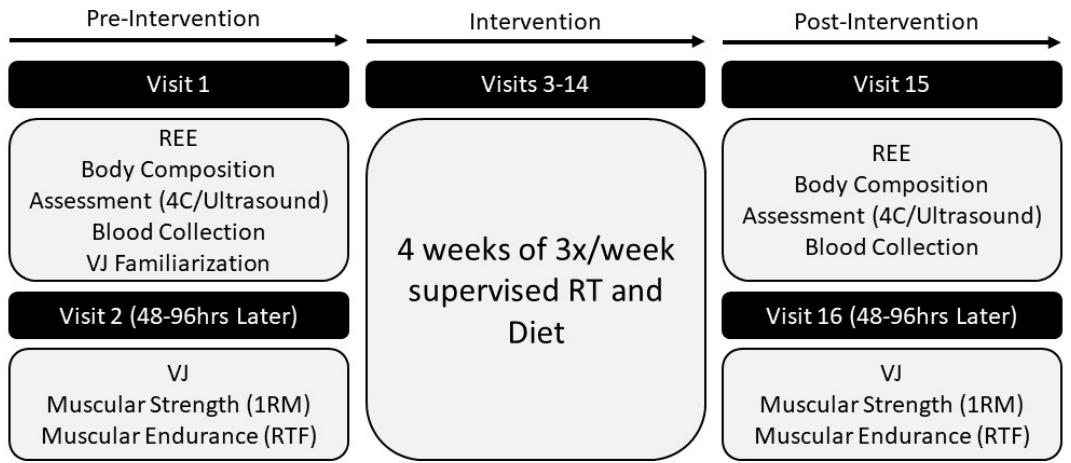
Figure 1. Study design overview. REE = resting energy expenditure; VJ = vertical jump; 4C = 4 compartment model of body composition; 1RM = 1 repetition maximum; RTF = repetitions until failure; RT = resistance training.